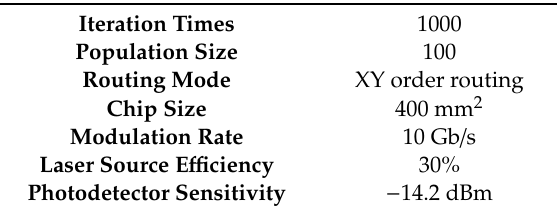
Table 1. Simulation parameters.